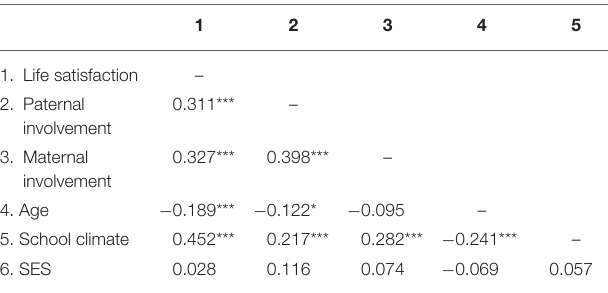
TABLE 2 | Pearson correlations among the main